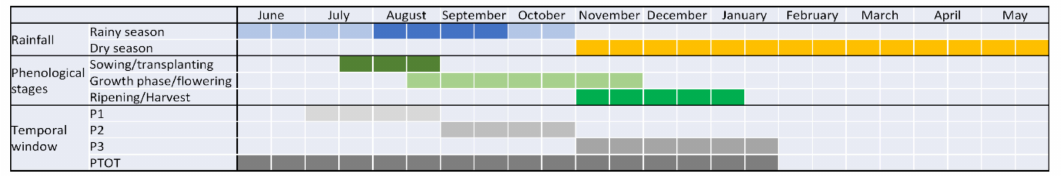
Figure 7. Calendar of rainfall, phenological stages, and temporal windows used for predictors